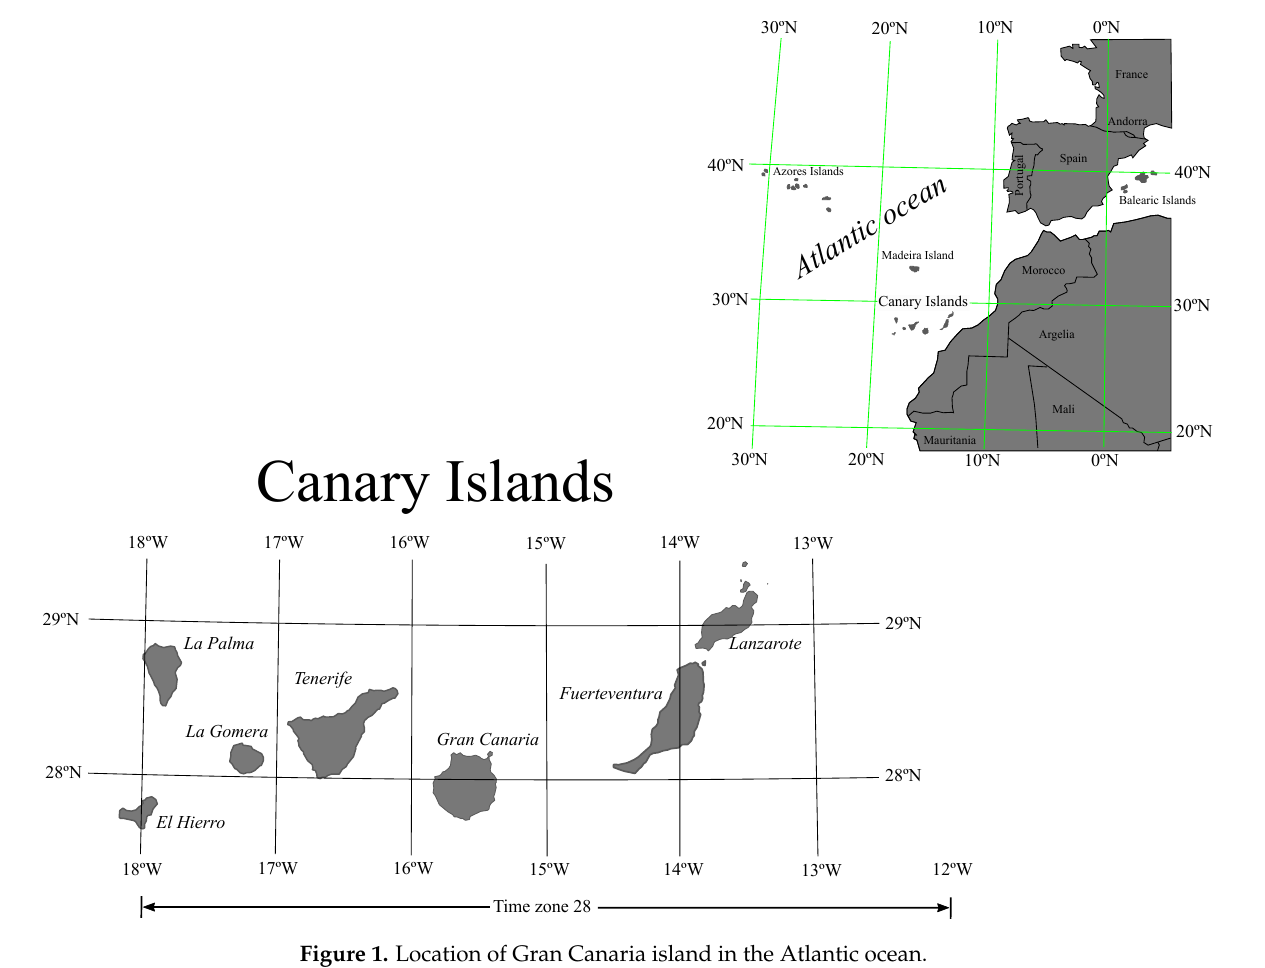
Figure 1. Location of Gran Canaria island in the Atlantic ocean.